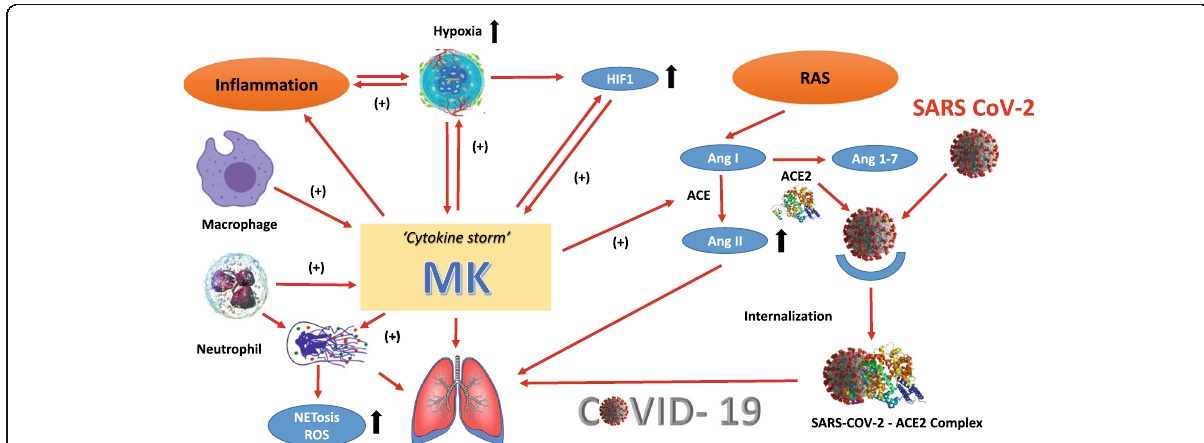
Fig. 1 Schematic representation of hypothetic actions of midkine in relation to SARS-CoV-2 infection. SARS CoV-2, severe acute respiratory syndrome coronavirus-2; RAS, renin-angiotensin system; Ang, angiotensin; ROS, reactive oxygen species; NETs, neutrophil extracellular traps; HIF-1, hypoxia-inducible